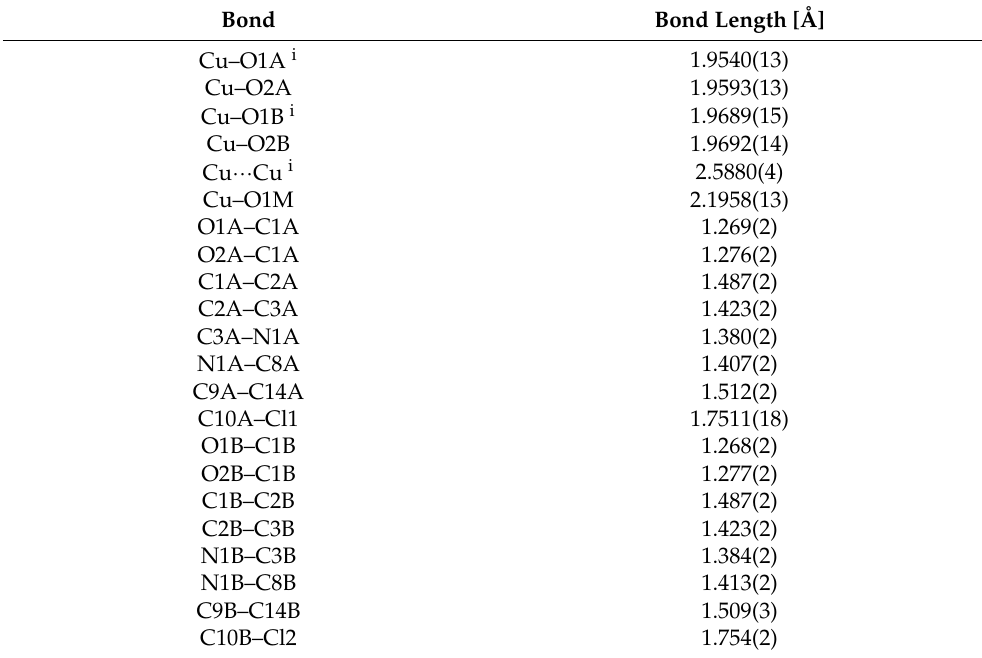
Table 2. Selected bond lengths in [Cu II 2 (Tolf) 4 (MeOH) 2 ] · 2MeOH.